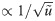
Average clone mass is set by mutation-expansion balance.The ensemble-averaged final mass of mutant clones 〈X〉 as measured from 1D simulations as a function of rescaled mutation rate, scaled by the expected dependence (∝1/u˜) for wavelike growth of clones. Results from different system sizes (symbols) are presented for each dispersal kernel quantified by μ (colours); the values are (from top to bottom) μ = {0.2, 0.6, 0.8, 1, 1.2, 1.4, 1.6, 1.8, 2, 3}. Each point represents an average over 20 or more independent simulations. Error bars denote measured standard deviation across repetitions. Dashed lines show the theoretical predictions for χ(u˜) for each dispersal kernel (see S1 Appendix, Section A for details), multiplied by a μ-dependent magnitude factor whose value is 1.5 for 1 ≤ μ < 2, 1.6 for μ > 2, and 1.65 for all other values.